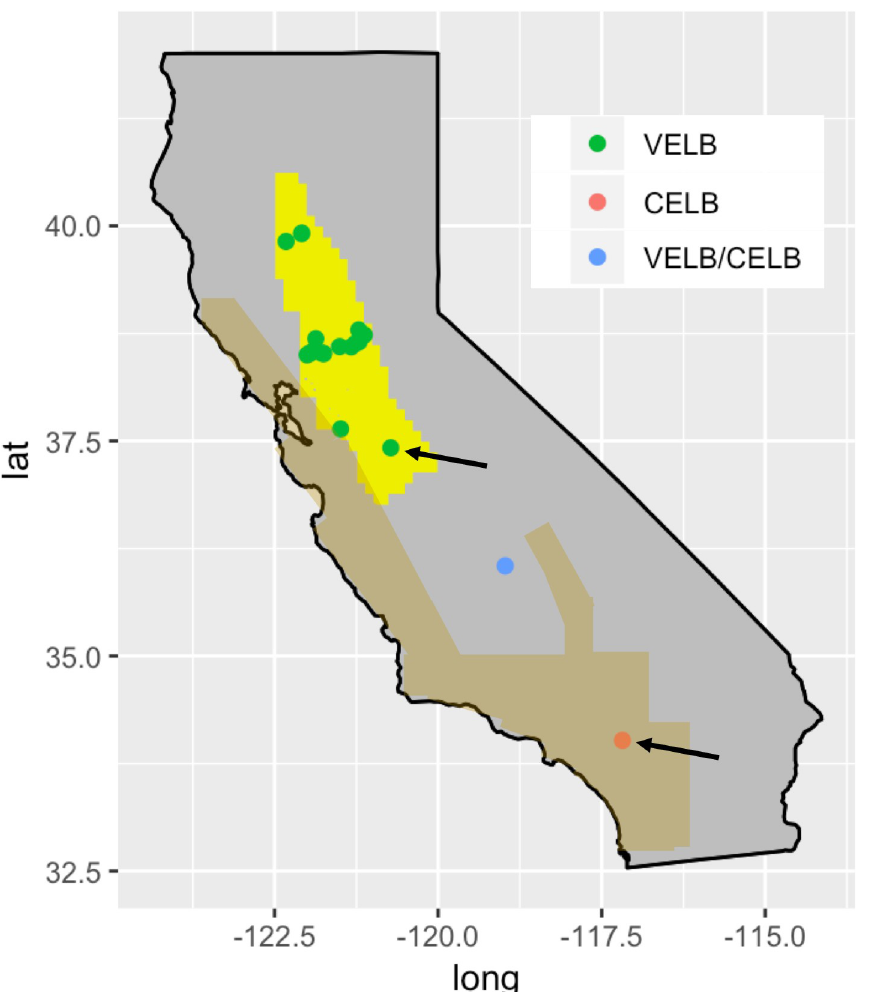
Fig 1. Map of VELB and CELB ranges within California. Individual points show frass collection locations that yielded sequencing data. One frass sample that was collected in the southern Central Valley outside of the VELB and CELB official ranges is labeled “VELB/CELB” to indicate uncertainty about which subspecies might be present. Arrows show locations where frass-derived sequences matched VELB or CELB museum specimens collected from nearby